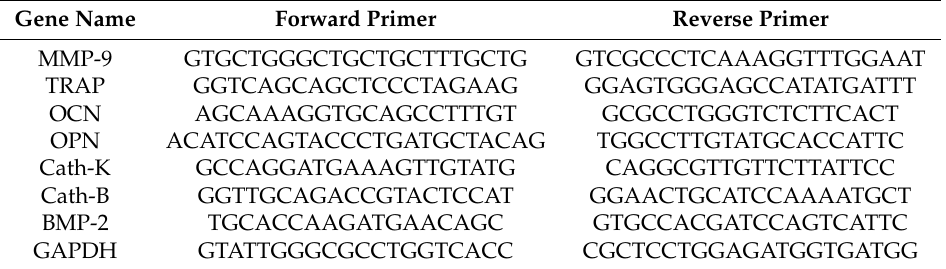
Table 3. Real time PCR primer